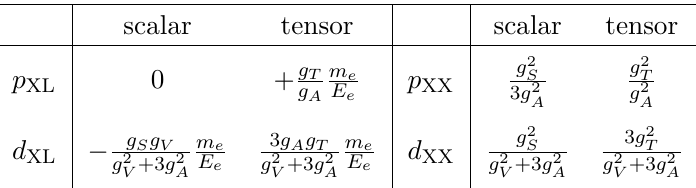
We can note that for ˜ (cid:15) the corrections on the probabilities involving the two first eτ families, which are the most relevant for solar neutrinos, are suppressed by the small value of θ . Indeed, we explicitly checked that the constraints on [˜ (cid:15) 13 are much weaker than those coming from reactor neutrino